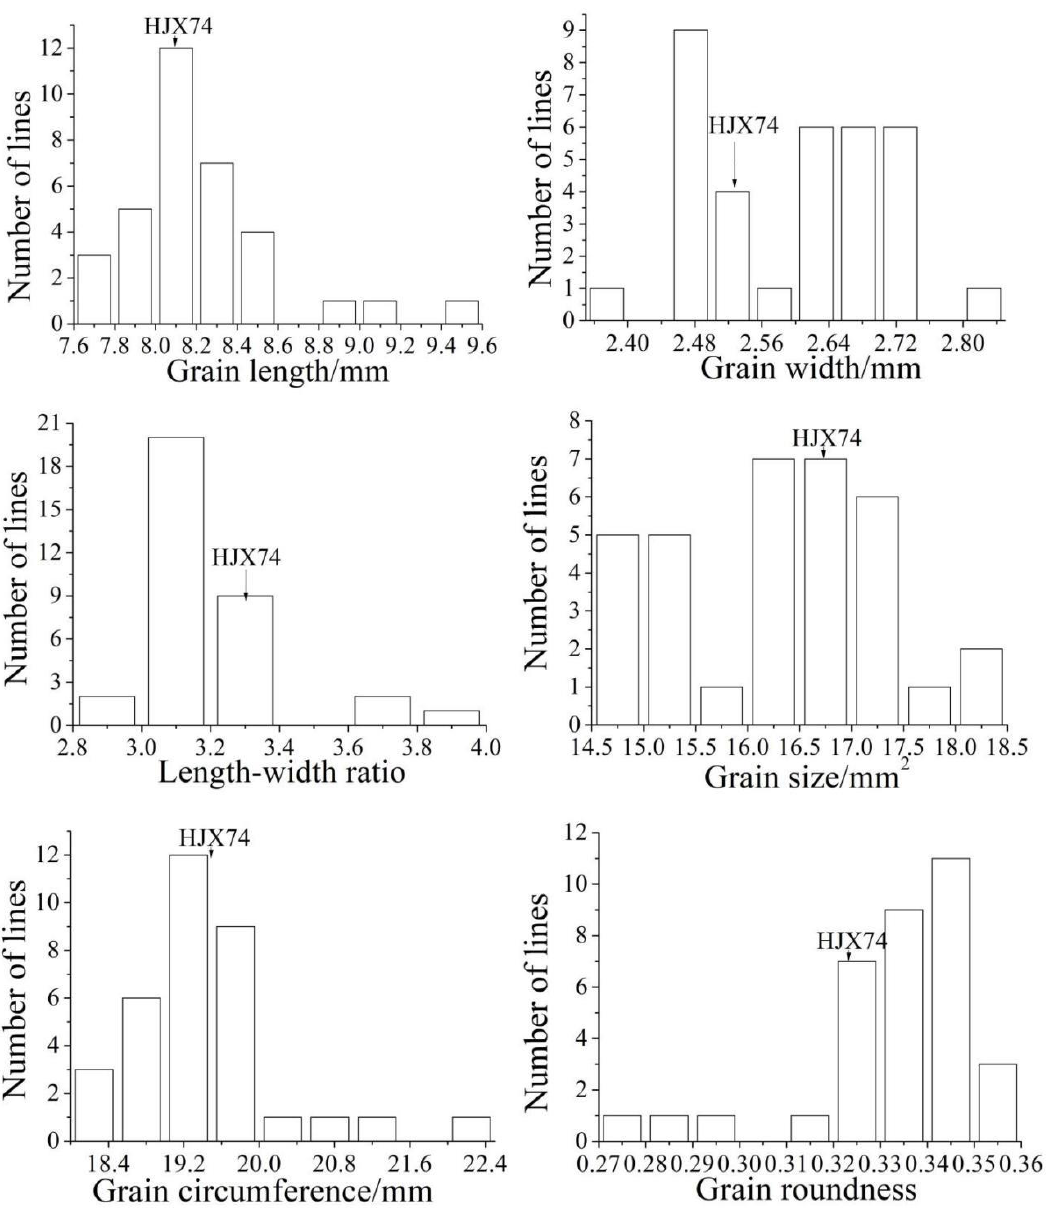
Figure 2. Frequency distribution of grain shape traits in SSSLs. Phenotypes of the receptor parent (HJX74) are indicated by arrows. Data are presented as the mean of 10 plants of each line in independent seasons.